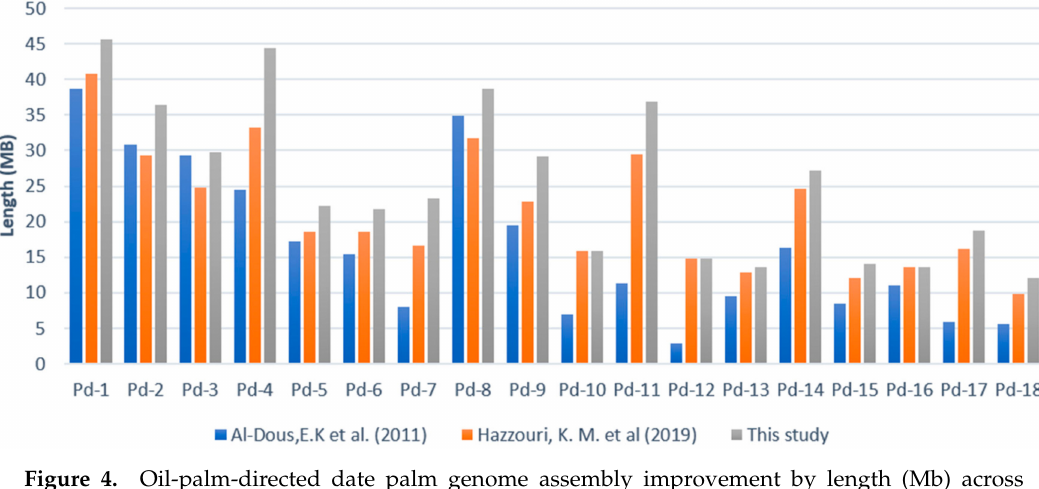
Figure 4. Oil-palm-directed date palm genome assembly improvement by length (Mb) across 18 pseudomolecules. Anchoring of sca ff olds was performed on the two published assemblies of date palm genome by Al-Dous et al. (2011) [34] and later by Hazzouri et al. (2019)